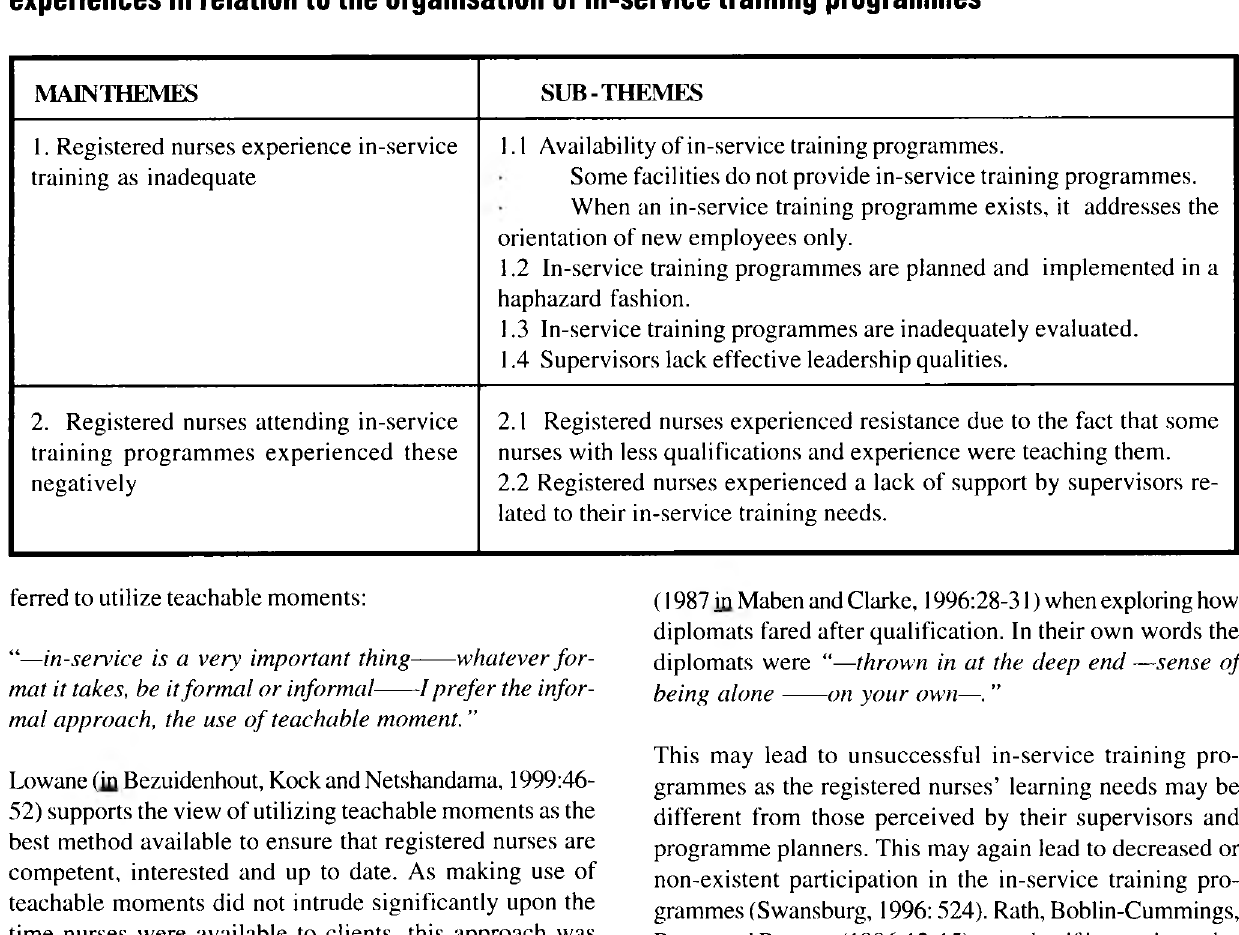
An overview of the main themes and sub-themes of the results of registered nurses’ experiences in relation to the organisation of in-service training